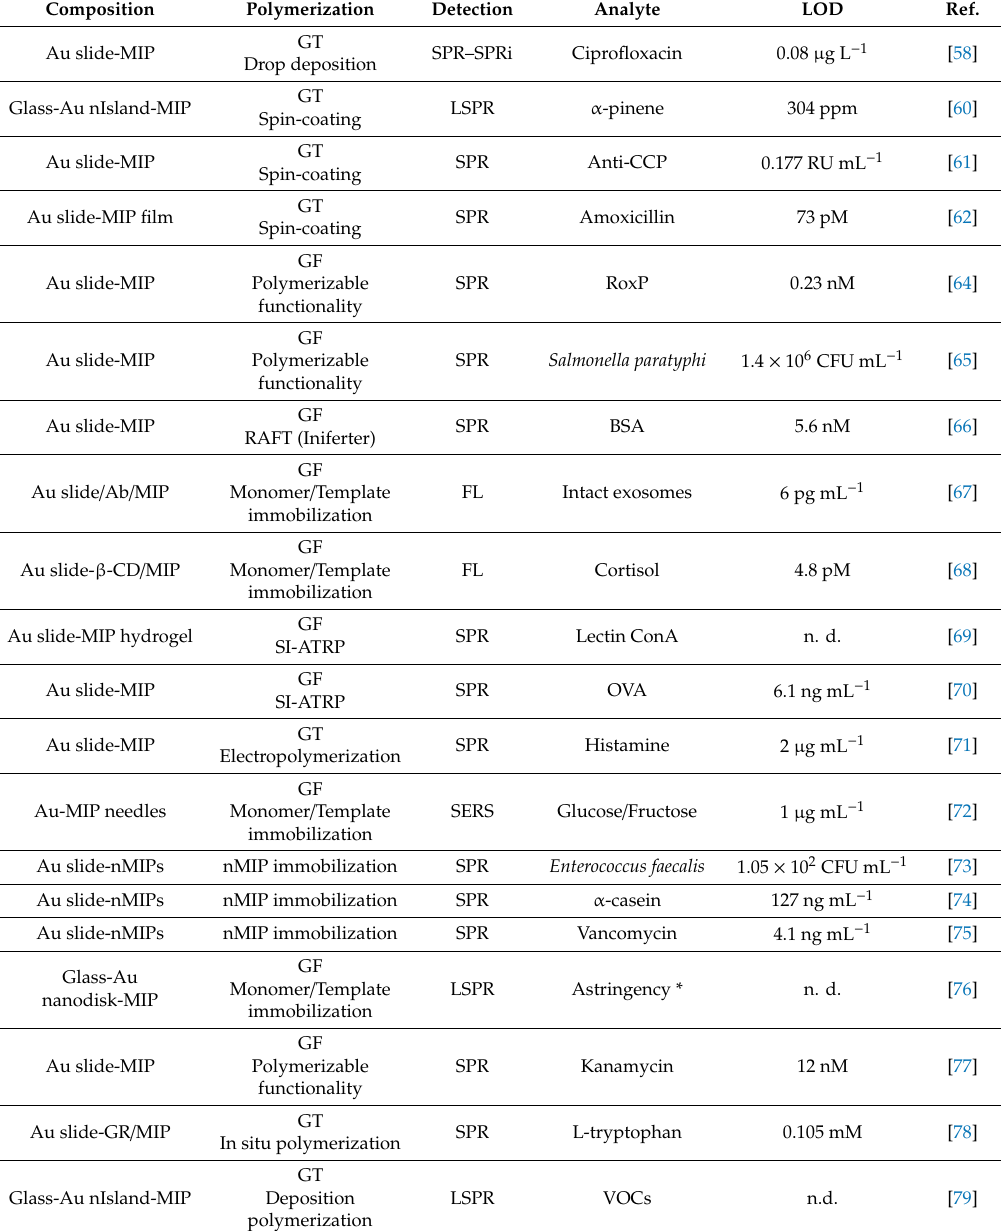
Table 1. Optical sensors based on MIPs deposited on the surface of a gold